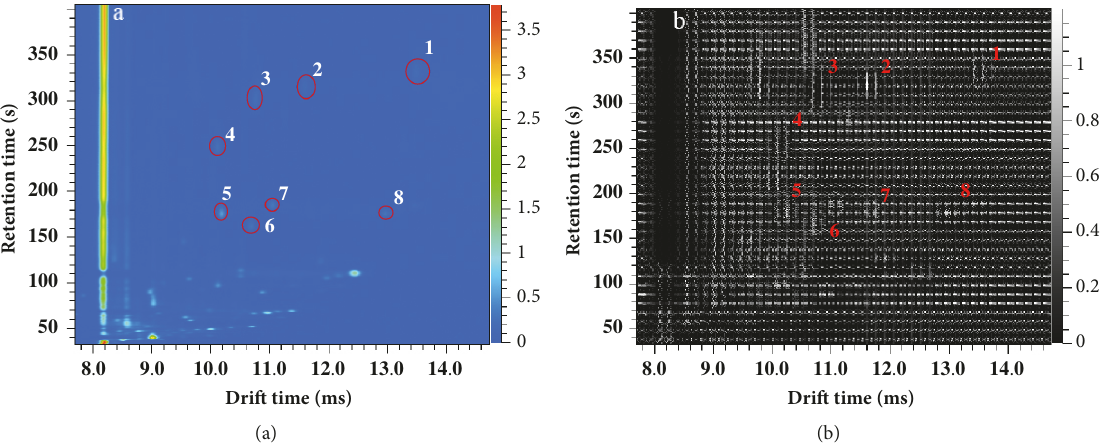
Figure 3: Visualization results of original data (a) and HOG feature extraction